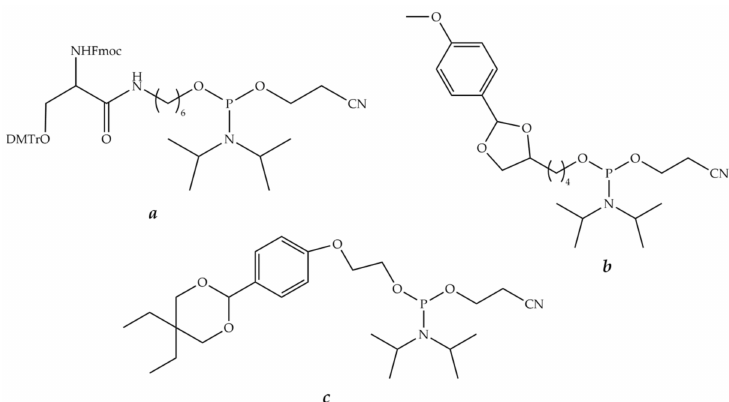
Figure 13. Masked phosphoramidite derivatives for the introduction of glyoxylic acid amide ( a ) and aldehyde ( b , c ) groups into oligonucleotides at the 5 (cid:48) -end. A similar strategy for the introduction of an aldehyde or a glyoxylic amide onto the 3 (cid:48) -end of an oligonucleotide was developed. Commercially available CPG supports (Figure 14a,b) can be employed to generate an aldehyde group after periodate cleav- age of the corresponding 1,2-diol or 1,2-aminoalcohol [275,276]. Another solid support (Figure 14c) was obtained from commercially available LCAA-CPG and N α -Fmoc- O - t - Bu-serine in several steps and used to produce a glyoxylic acid amide upon periodate oxidation [277]. Oligonucleotides having aldehyde or glyoxylic acid amide groups were obtained in the same